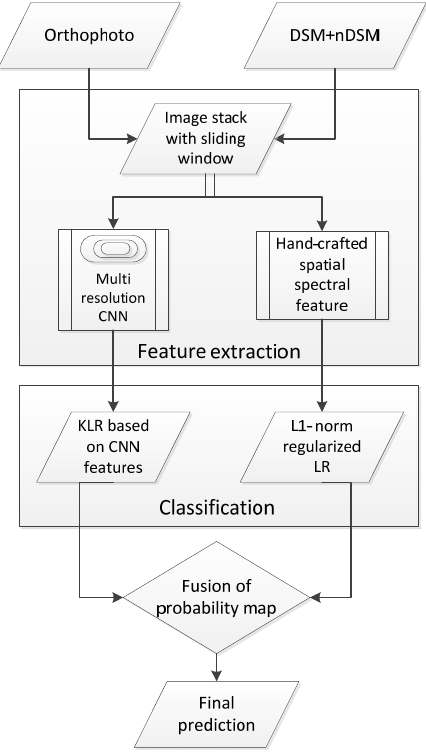
Figure 1. Workflow for the proposed pixel labelling